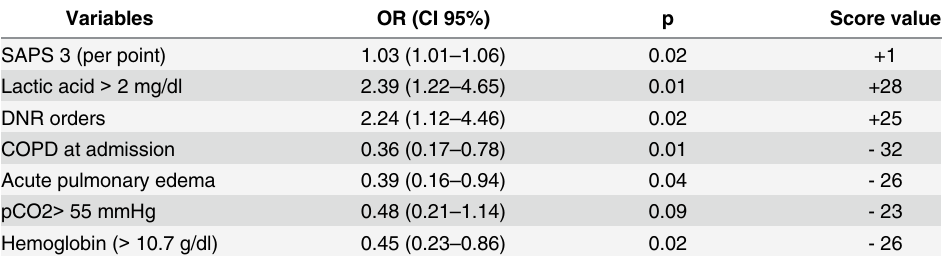
Table 6. Logistic regression and score customization for SAPS